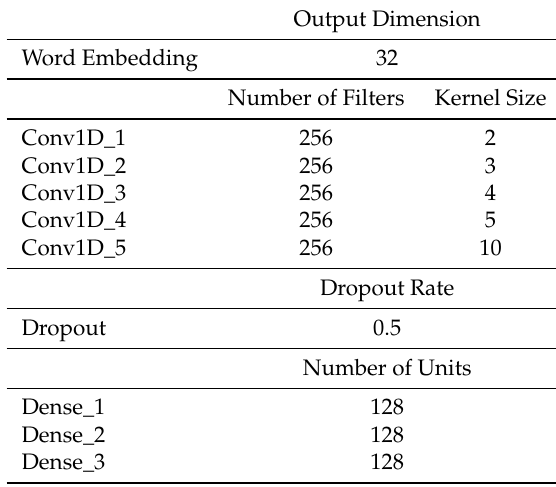
Figure 8. Structure of the proposed DNN model. Table 1. Architecture configuration of the proposed DNN